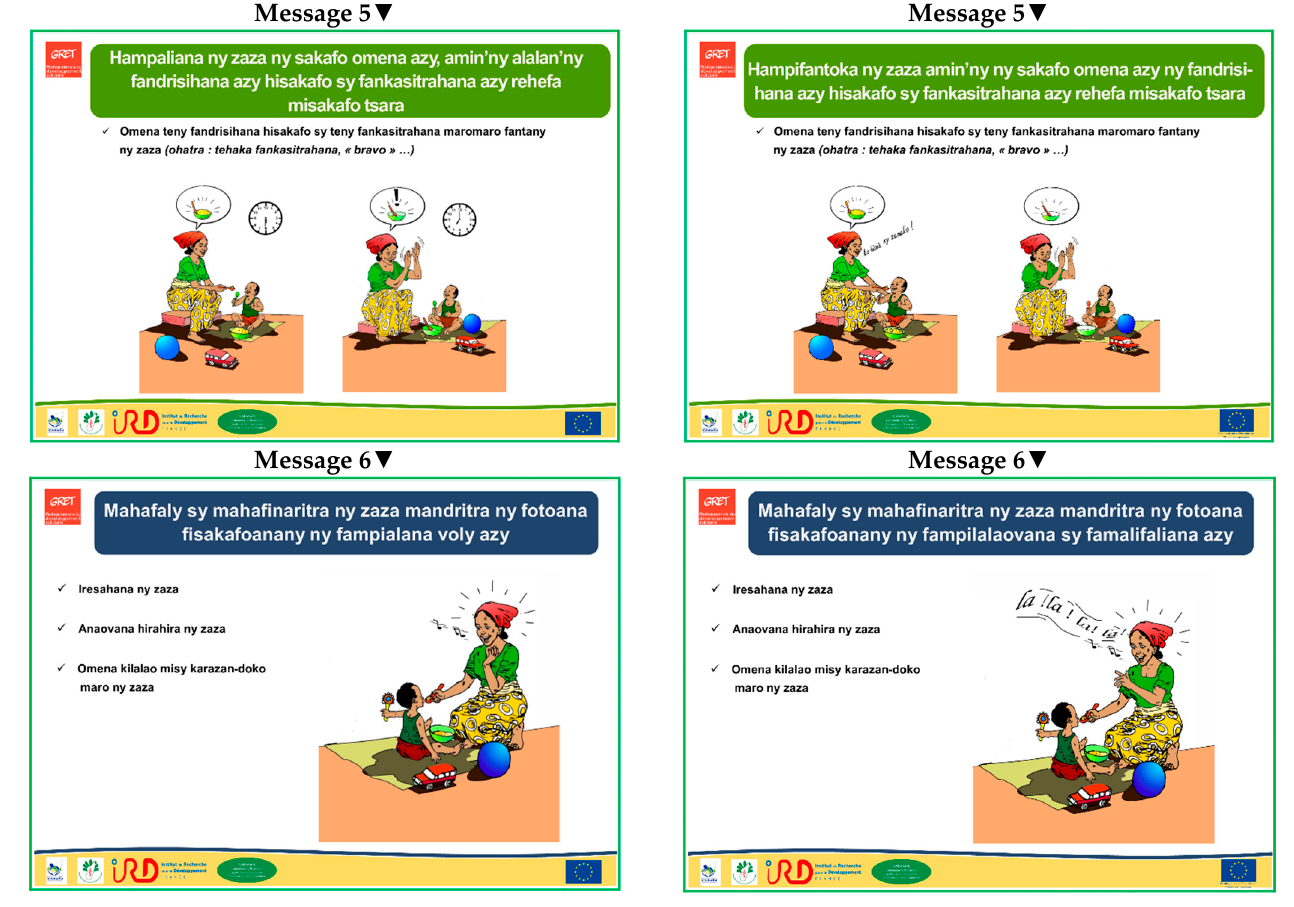
Figure 1. Counselling cards illustrating the six key messages to promote responsive feeding before ( left panels ) and after ( right panels ) validation by the community.